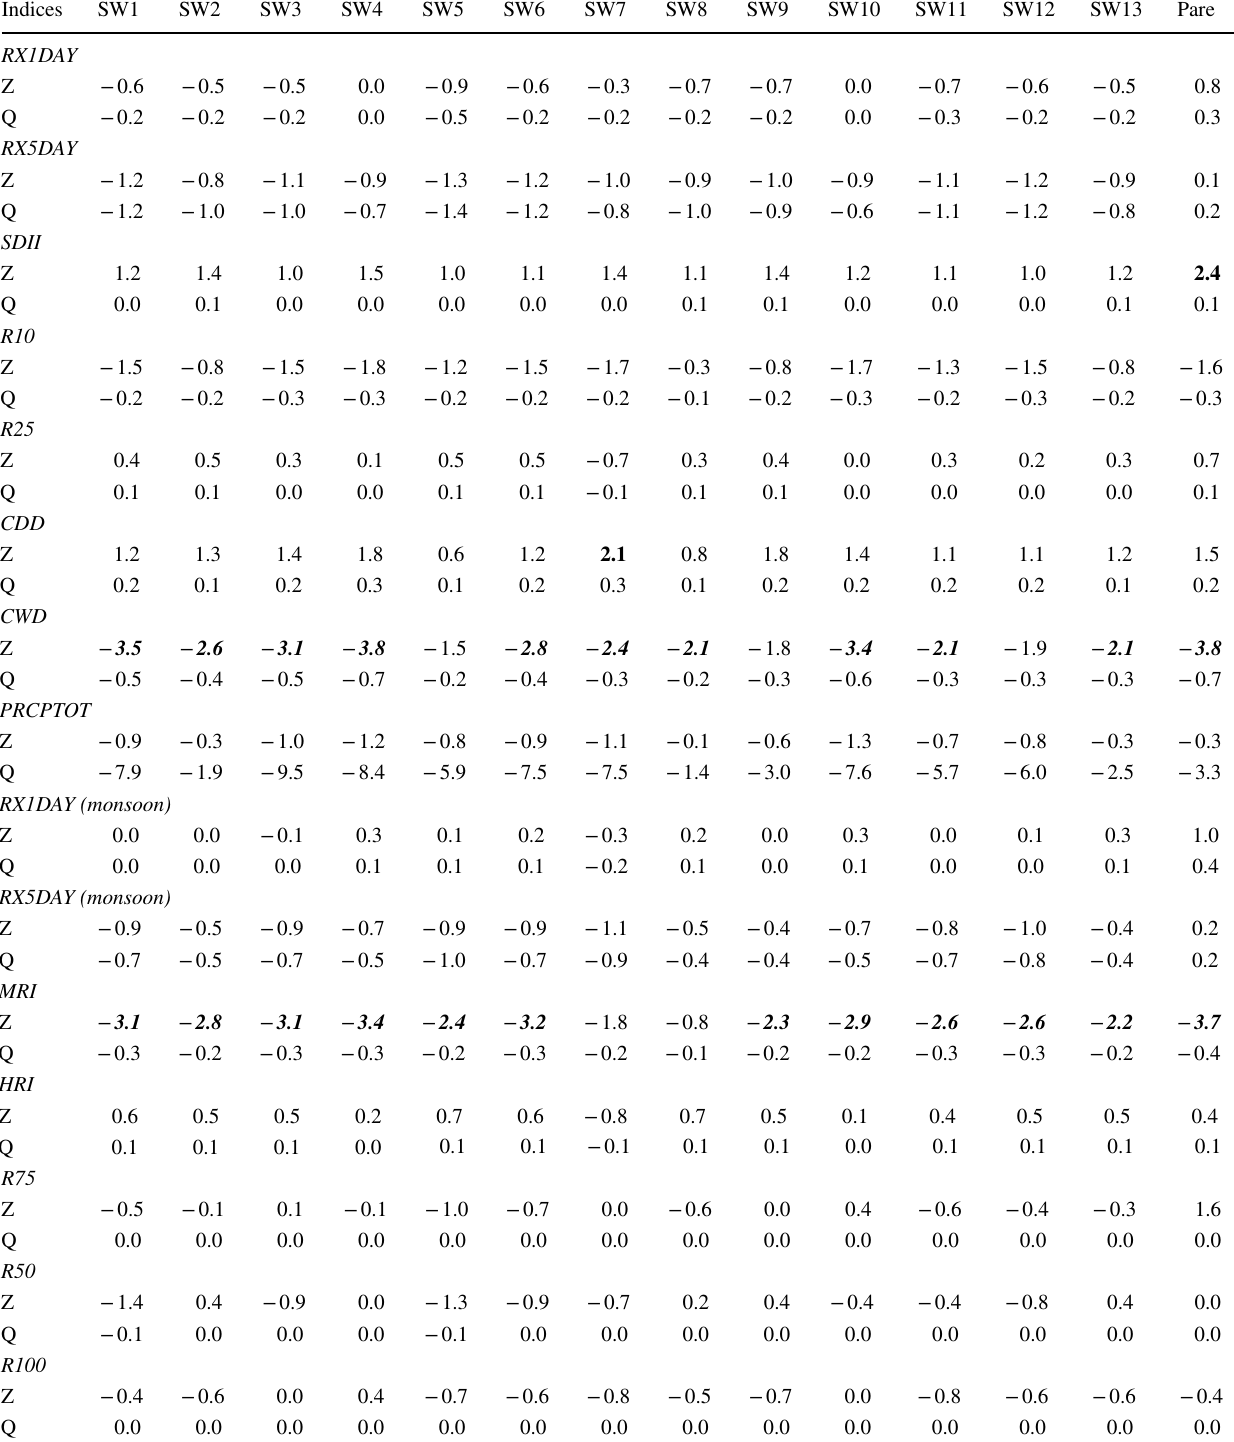
Table 2 Trend directions and magnitudes for various precipitation extremes during